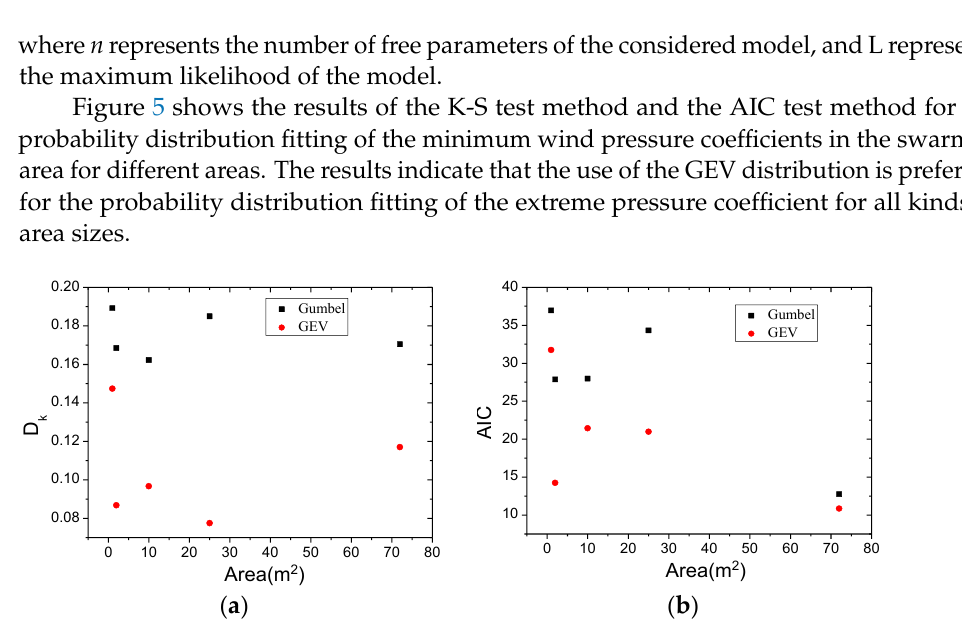
Figure 5. Examination of probability distribution fitting goodness of extreme pressure coefficients. ( a ) D K value in swarmed area. ( b ) AIC value in swarmed area.